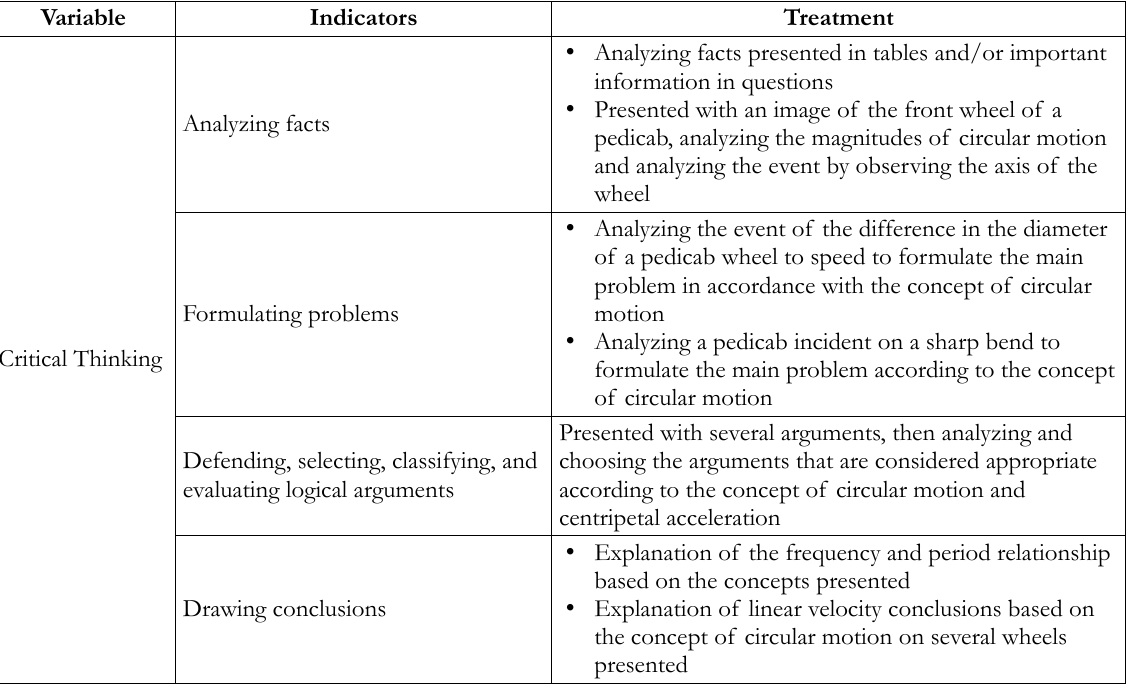
Table 2. Matrix of variable and treatment